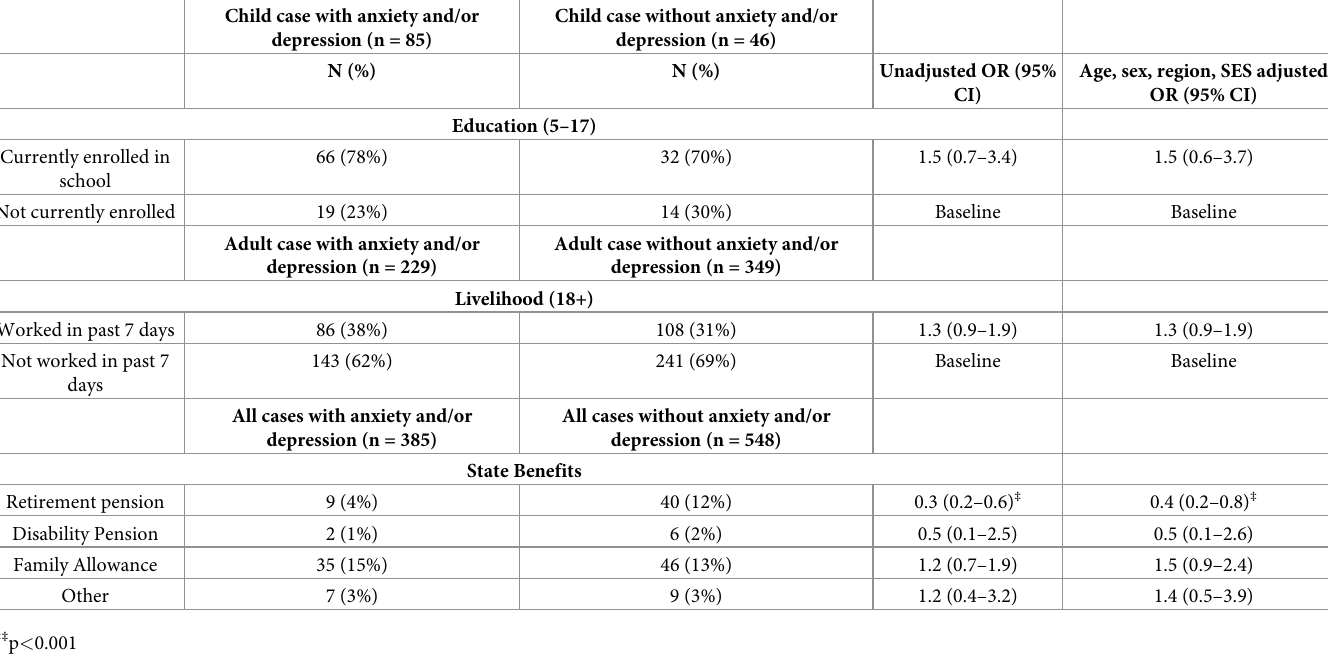
Table 6 compares health advice and treatment between cases with and without anxiety and/or depression. Again, a range of indicators were included due to the broad impact of mental health conditions on healthcare access shown in past studies [27]. Cases with anxiety and/or depression were nearly twice as likely to report a serious health problem in the last 12 months Table 4. Education (5–17) and livelihood (18+), comparing cases with and without anxiety and/or depression. Child case with anxiety and/or Child case without anxiety and/or depression (n = 85) depression (n =